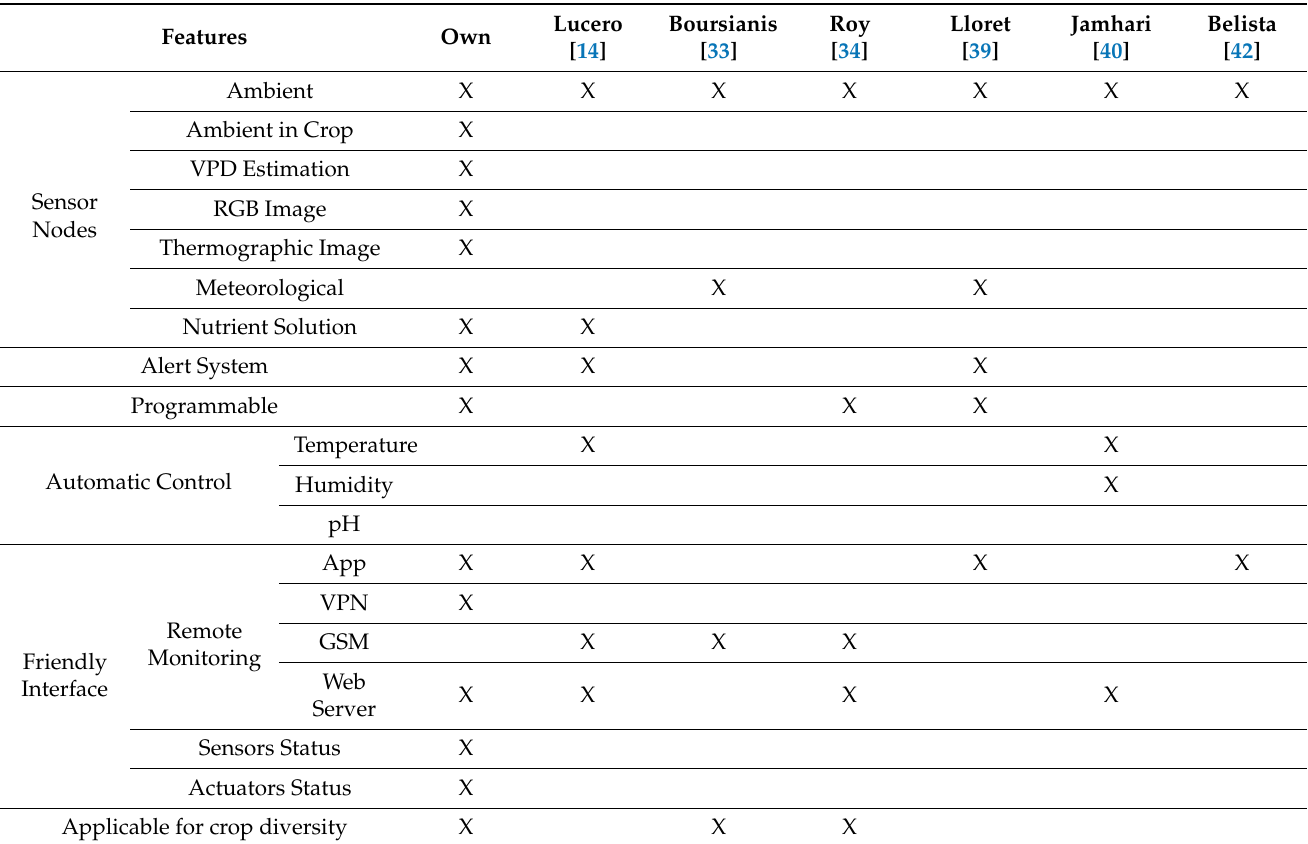
Table 5. Comparison with related